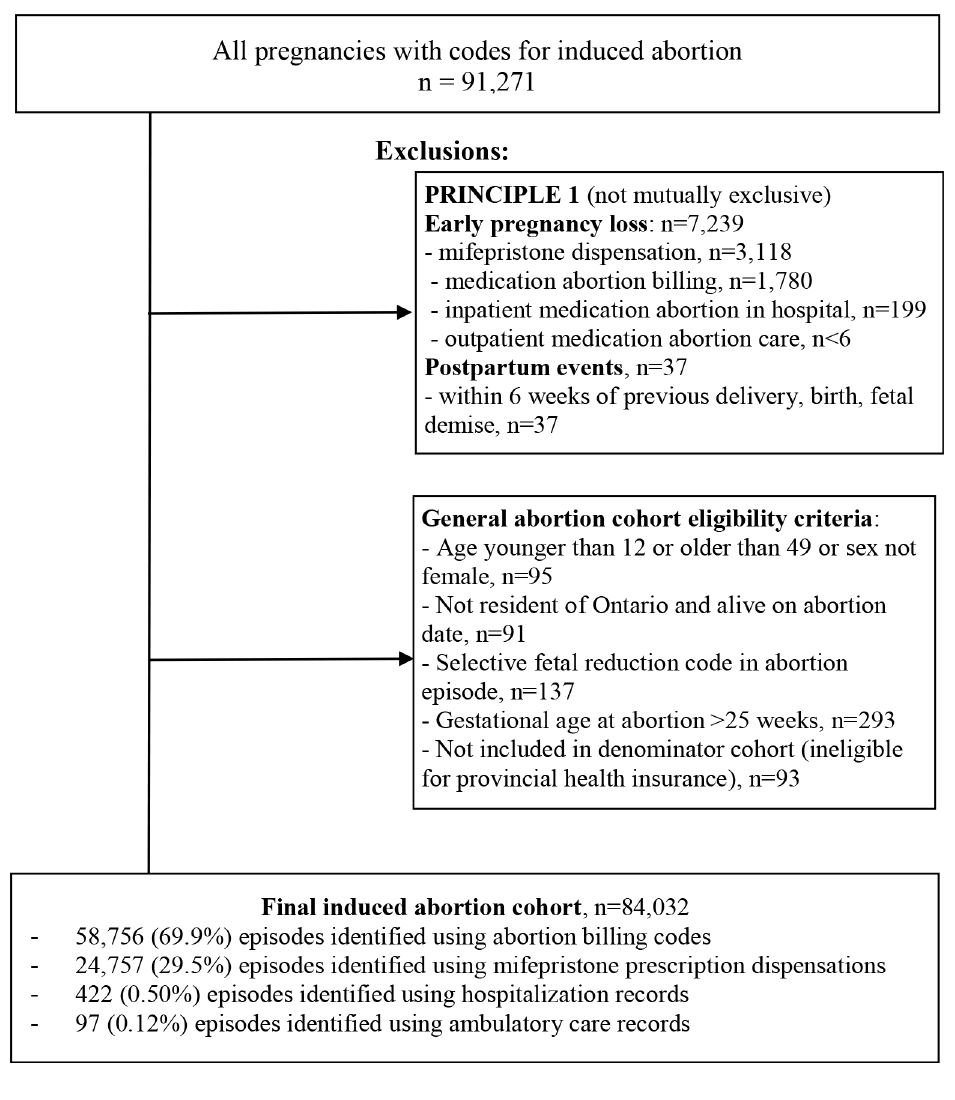
Figure 1: Study population derivation: induced abortion episodes identified by linking physician billing, hospitalization,